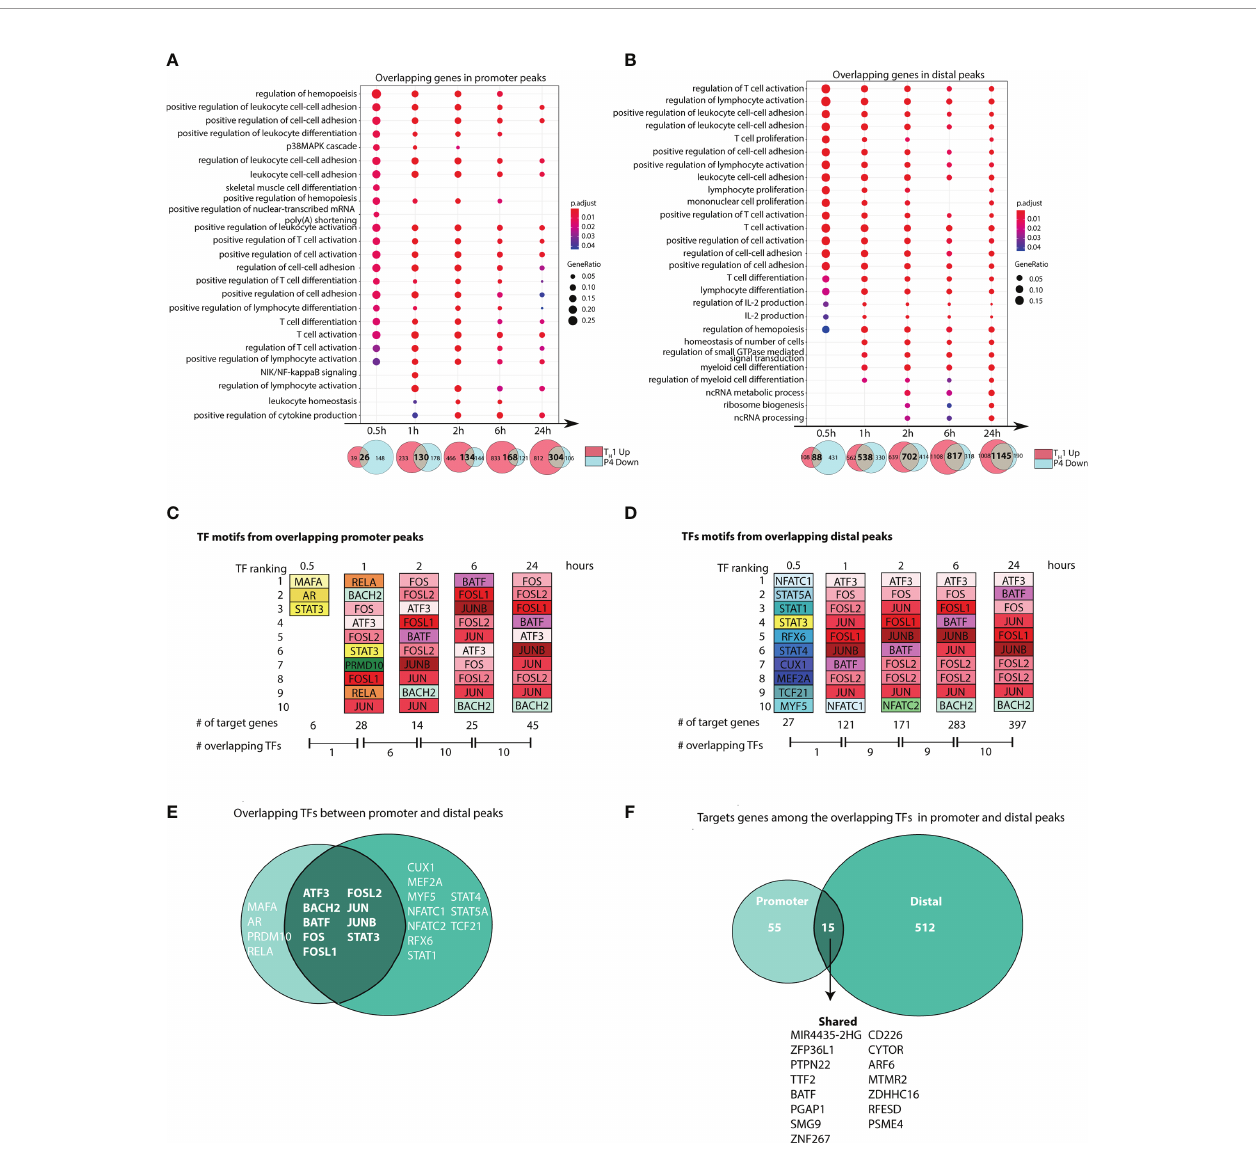
FIGURE 3 | Progesterone downregulates T-cell responses induced during T H 1 differentiation. Naïve primary human CD4 + T cells were differentiated in the presence or absence of P4 to evaluate the in fl uence of P4 on T H 1 differentiation. Correlation between ATAC-seq and RNA-seq was performed to identify changes that were present in both omics. (A, B) Gene Ontology pathway enrichment analysis of the overlapping genes between peaks that were upregulated during T H 1 differentiation and downregulated by P4. Venn diagrams shown below highlight the overlapping genes between the genes upregulated in T H 1 and downregulated with P4, where the intersection was used for the gene set enrichment. (C, D) Top 10 transcription factors derived from motif enrichment analysis of the intersecting peaks between T H 1 up and P4 down at each time point. The TFs are colored in the same color among the same TF and between promoter and distal. A TF can appear more than ones for each time point since different motifs from the same TF are present. Number of target genes regulated by these TFs and the number of shared TFs between the time points are given below. All TFs are signi fi cantly enriched compared to time point 0 (resting; p < 0.05) at each respective timepoint they appear. (E, F) Venn diagram showing the number of overlapping and unique target genes and TFs enriched in the promoter and distal peaks comparing genes upregulated during T H 1 and downregulated with P4. GO, gene ontology; P4, progesterone; TF, transcription factor; T H 1, T helper 1